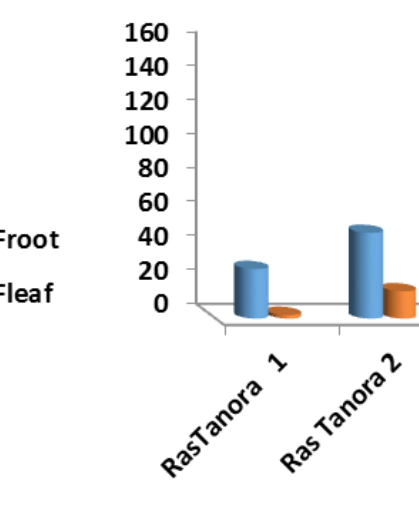
Figure 3: Bio-accumulation factors in roots and leaf for phenanthrene in mangrove plants in the study